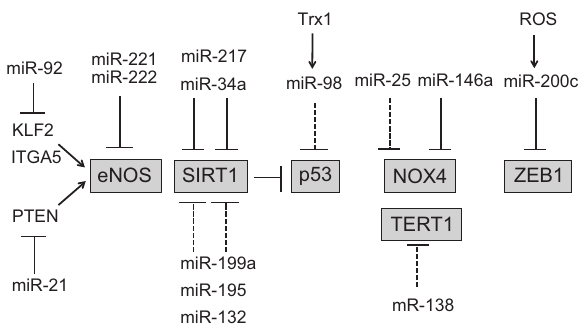
Figure 1 Regulation of endothelial senescence by miRNAs. The major molecules in endothelial senescence are regulated by a variety of miRNAs. Dashed lines indicate miRNAs reported in non- endothelial